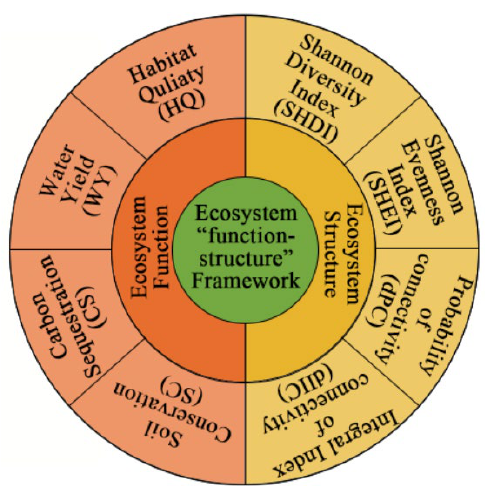
Figure 3. Ecosystem “function-structure” conceptual framework.